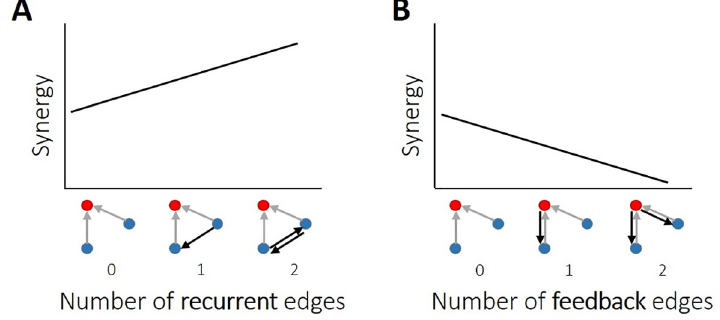
Fig 11. Summary of findings regarding how synergy is related to recurrent and feedback information flow in organotypic cultures of mouse cortex. (A-B) Synergy had a positive relationship with the number of recurrent edges and a negative relationship with the number of feedback edges. That is, synergy was elevated where there was greater upstream recurrent information flow. Synergy was diminished where there was greater feedback information